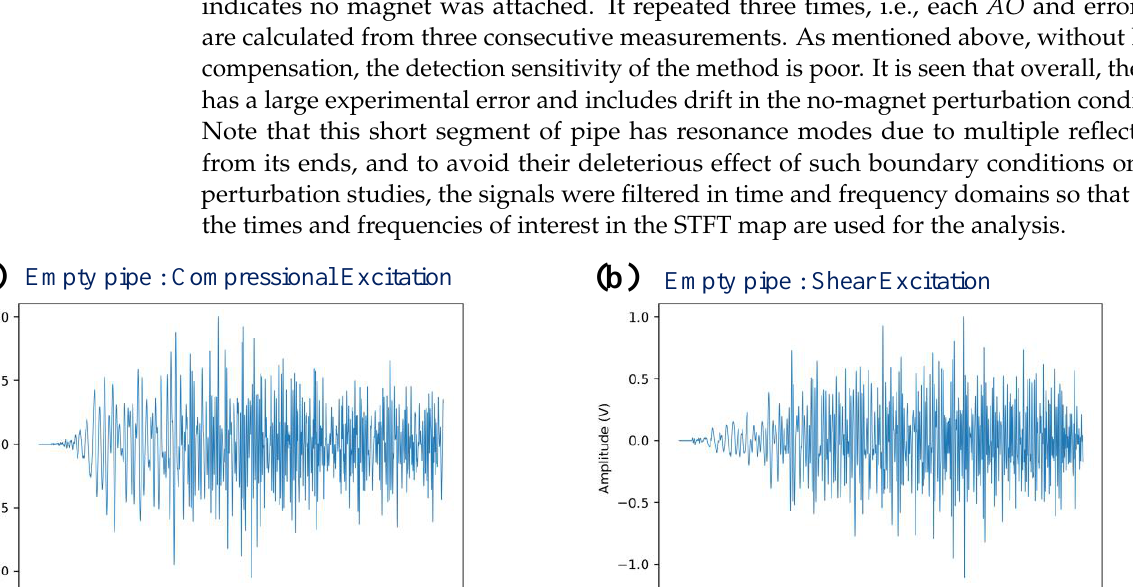
Figure 6. Time domain signals for the empty pipe with compressional ( a ) and shear ( b ) excitations.